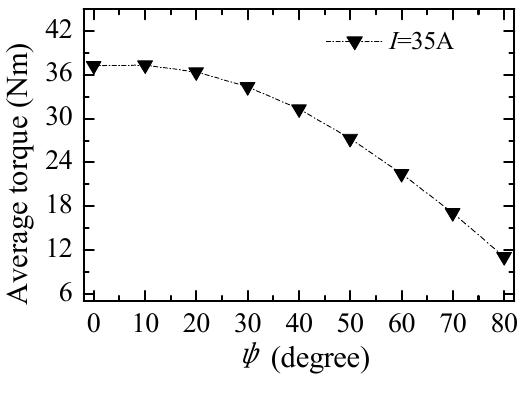
Figure 9. Torque versus ψ when rms value of the current is 35 A.